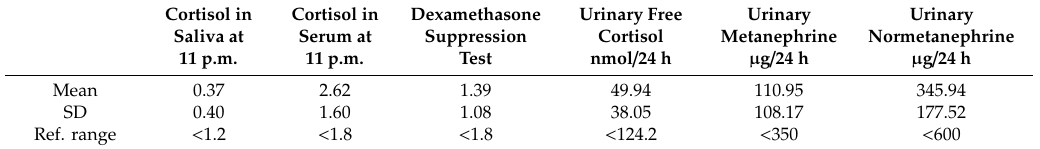
Table 1. Results of hormonal tests performed to exclude hypercortisolism and pheochromocytoma. Cortisol in Cortisol in Dexamethasone Saliva at Serum at Suppression 11 p.m. 11 p.m. Test nmol / 24